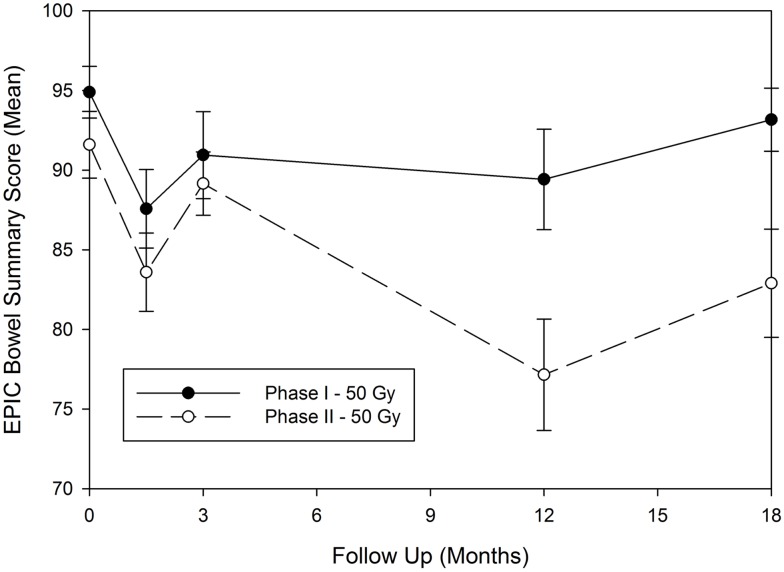
Expanded prostate cancer index composite-bowel summary score for patients treated in the 50 Gy dose group for the phase I and phase II studies. EPIC, expanded prostate cancer index composite; Gy, gray.